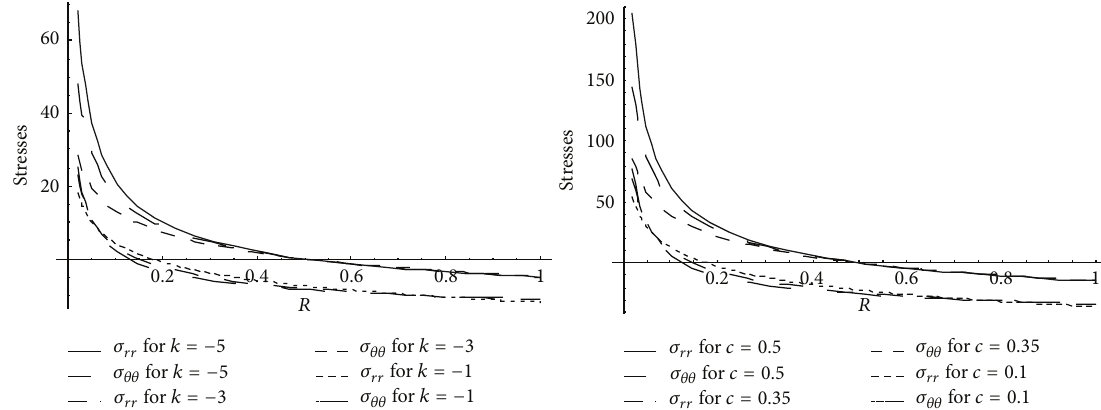
Figure 5: Homogeneous transitional stresses for a thick-walled circular cylinder under external pressure ( 𝑃 2 = 5 and 15).